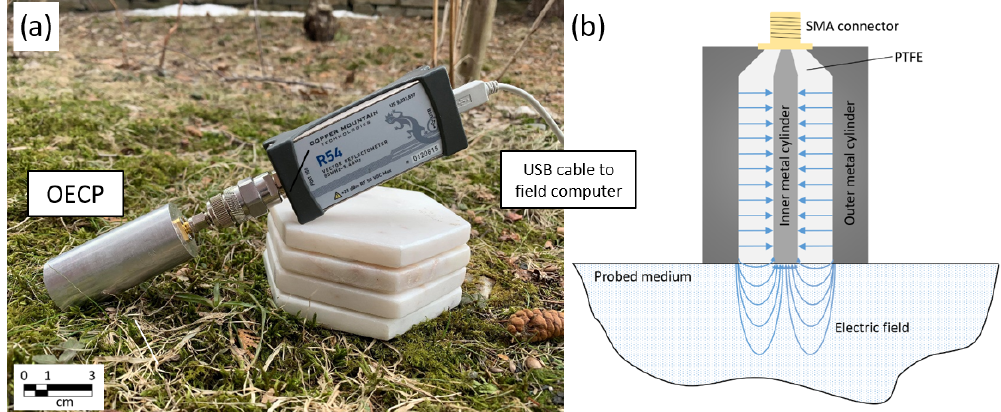
Figure 1. (a) OECP for permittivity measurements. The control program provided by the Planar R54 reflectometer manufacturer is operated with a field computer. The probe is connected to the Planar R54 reflectometer using a SMA/N cable or adaptor. (b) Diagram of the electrical field produced by the OECP.